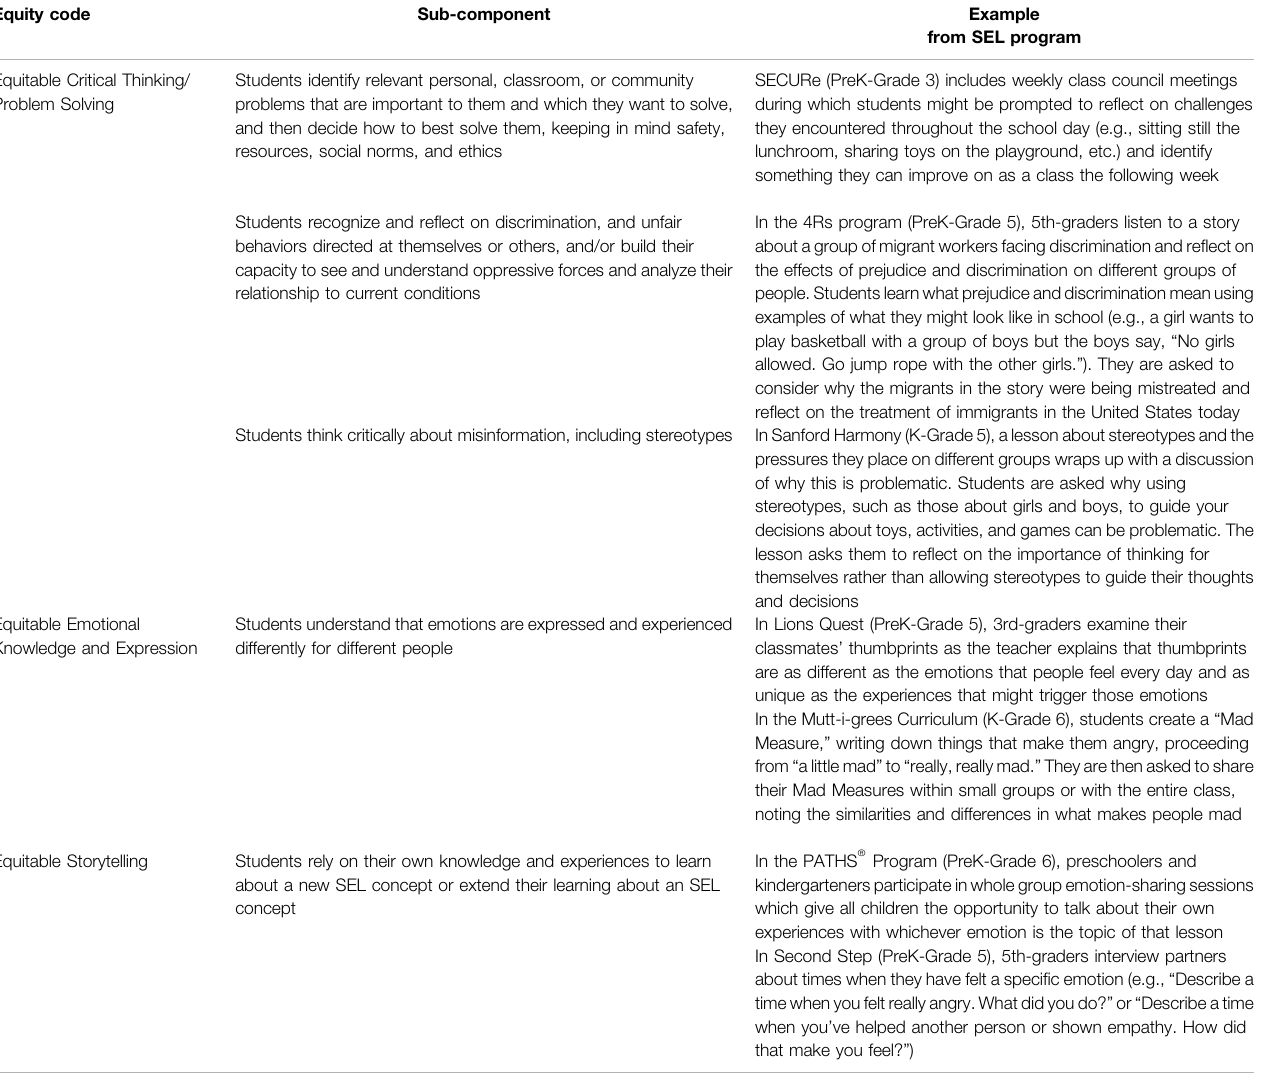
TABLE 2 | Examples of equitable SEL inside existing SEL